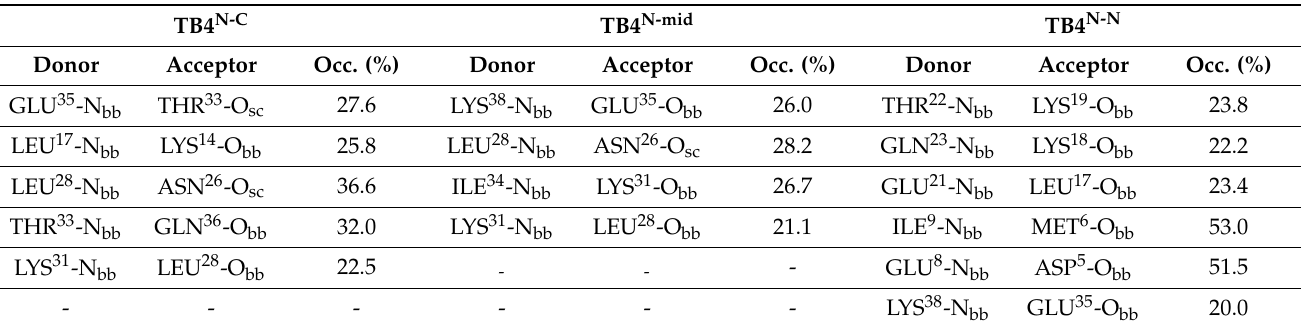
Table 2. Percentage of hydrogen bond and salt bridge occupancies during the simulations. bb: back- bone, sc: side